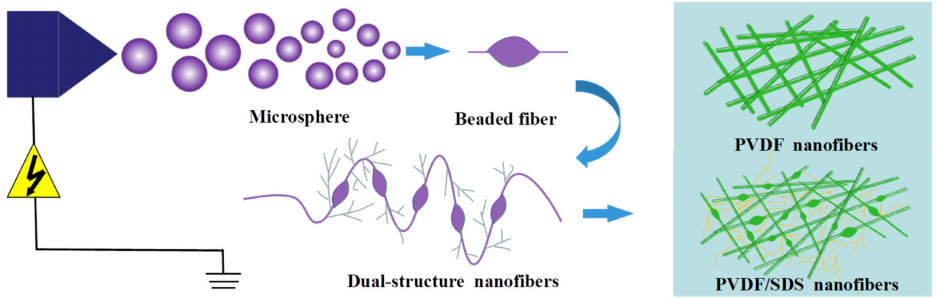
Figure 4. Forming mechanism of PVDF/SDS